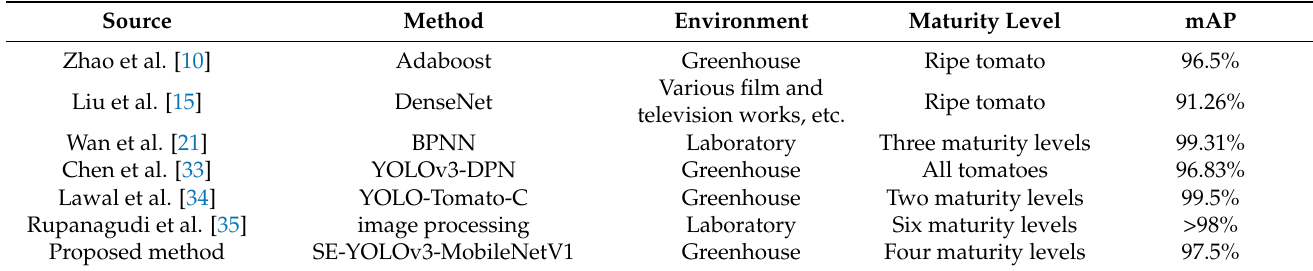
Table 4. The proposed method is compared with existing